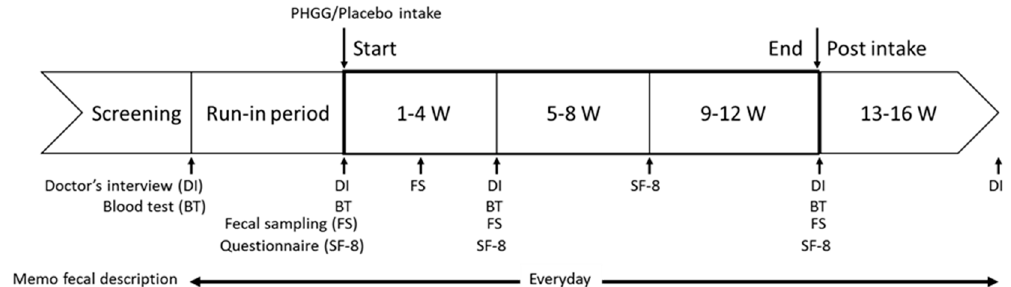
Figure 1. Test schedule.